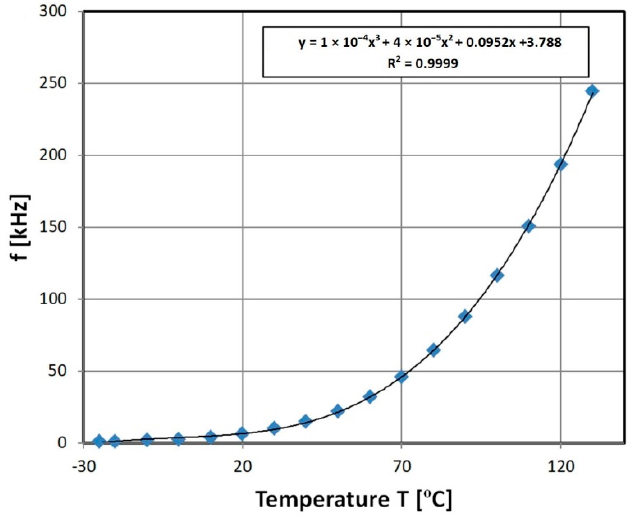
Figure 12. Exemplary results of N type thermistor with 555 transducer output characteristics.